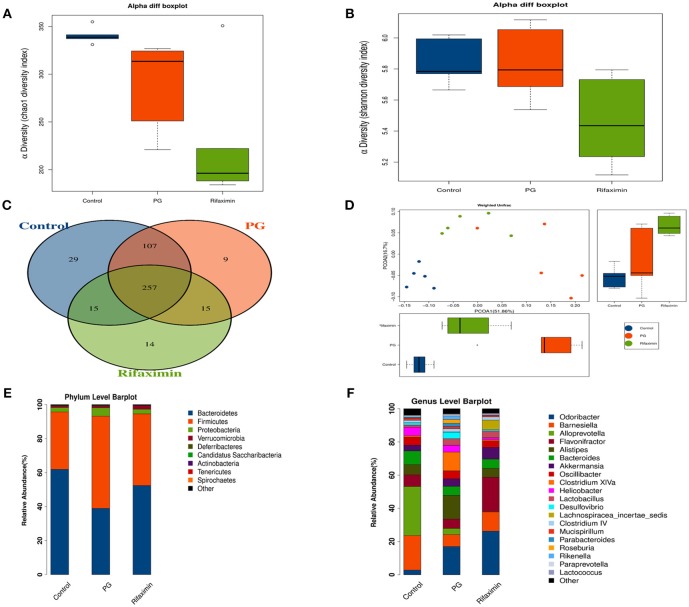
Rifaximin modulates the composition of the microbiota in AS mice. (A) Chao1 index and (B) Shannon index for the three groups. (C) Venn diagram of shared and unique OTUs among different groups. (D) Principle coordinate analysis (PCoA) of weighted UniFrac distances. Analysis of the composition of bacteria present at phylum (E) and genus levels (F). (n = 5 mice per group).